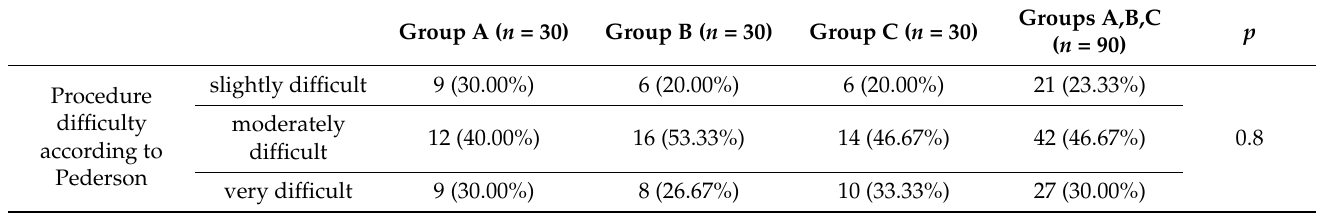
Table 2. Results of comparative analysis of the scale of procedure difficulty according to Pederson’s classification between groups A, B,